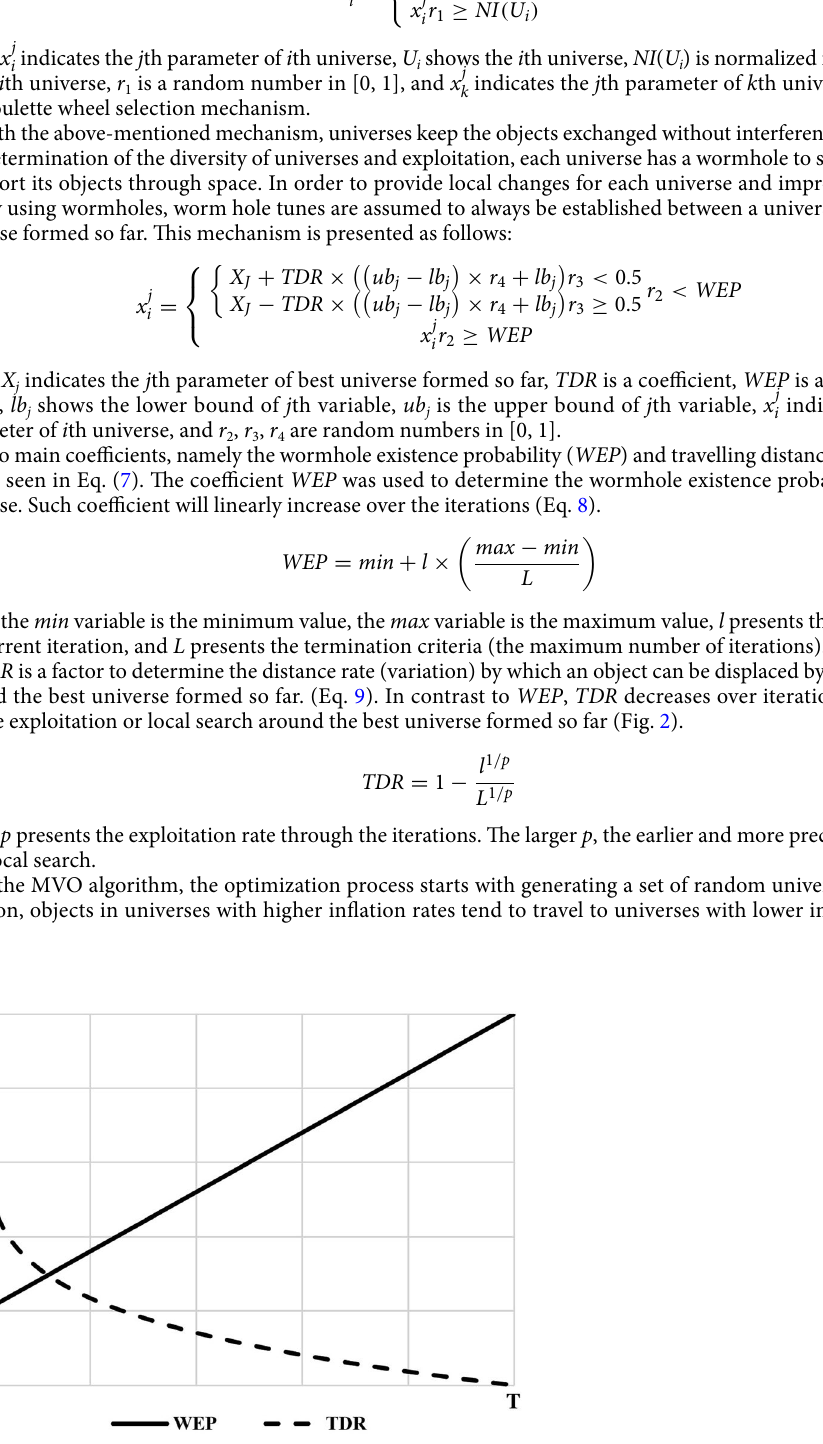
Figure 2. Wormhole existence probability (WEP) versus travelling distance rate